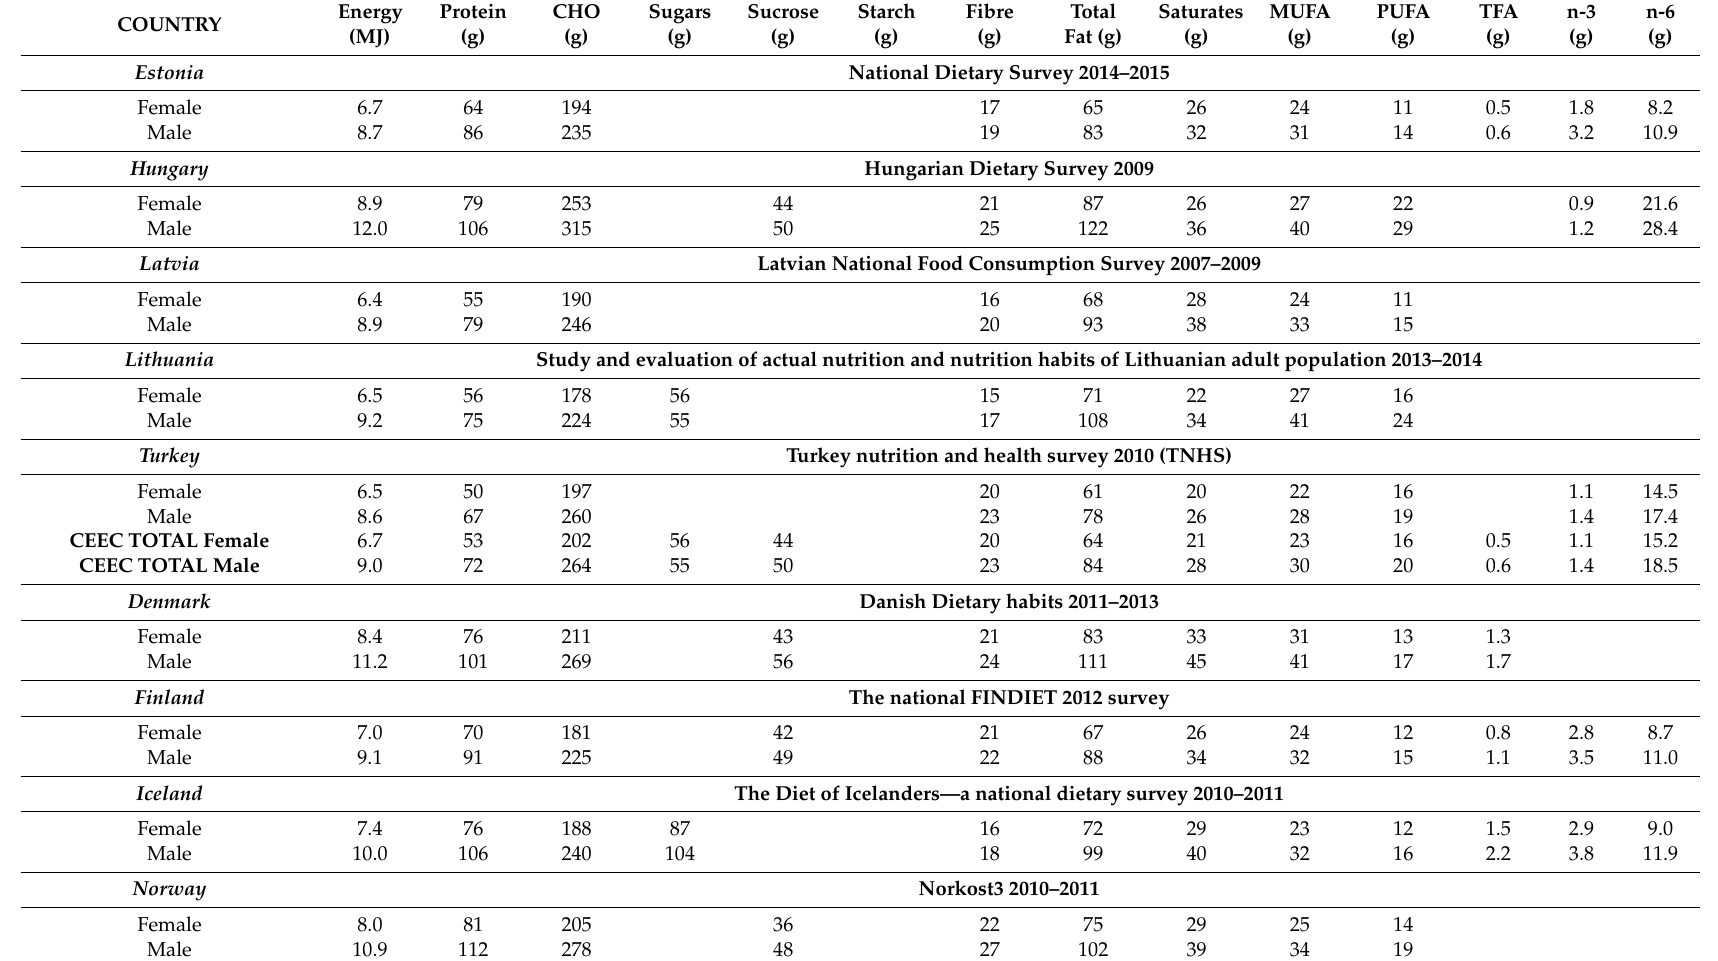
Table 4. Weighted means * by country for macronutrient in 21 national dietary surveys in the WHO Europe